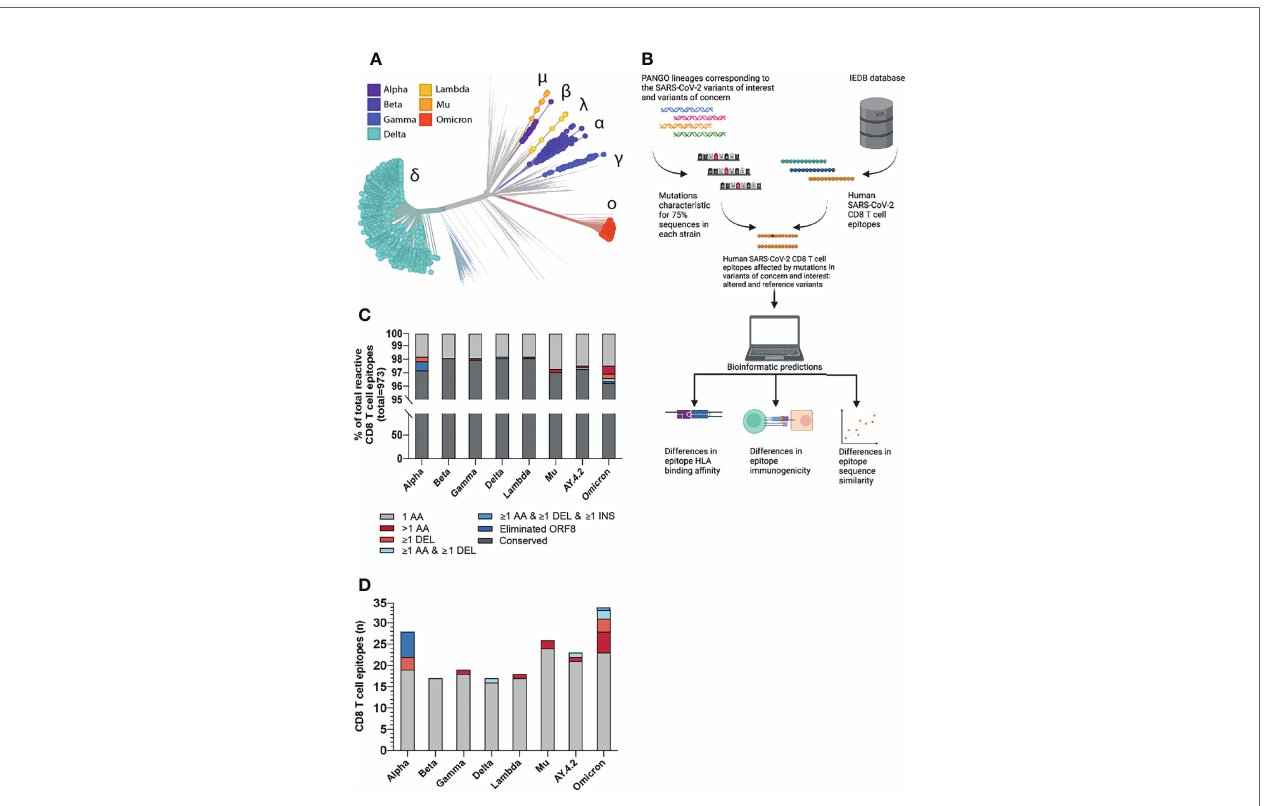
FIGURE 1 | Overview of the investigated SARS-CoV-2 CD8 T cell reactive epitopes. (A) Phylogenetic tree where isolates originating from variants of concern (VOCs) Alpha, Beta, Gamma, Delta and Omicron are highlighted, as well as variants of interest (VOIs) Lambda and Mu. AY.4.2 is a subvariant of Delta and overlaps with the Delta branch. The length of the branches re fl ects the time of emergence. Visualization generated using the Nextstrain platform (22). (B) Depiction of the project work fl ow. Created with Biorender. (C) Stacked bar graph indicating the percentages of CD8 T cell recognized epitopes per variant that are conserved or harbor the indicated types of mutations. (D) Numbers of CD8 T cell recognized epitopes per variant that harbor the indicated types of